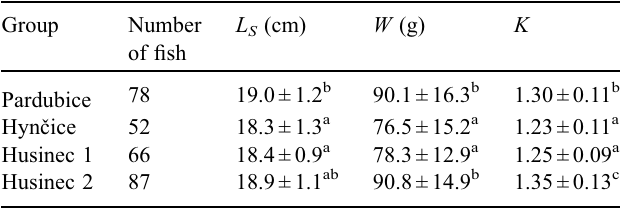
Within a column, different superscripts symbols indicate signi fi cant difference ( P < 0.05) determined by post hoc Tukey